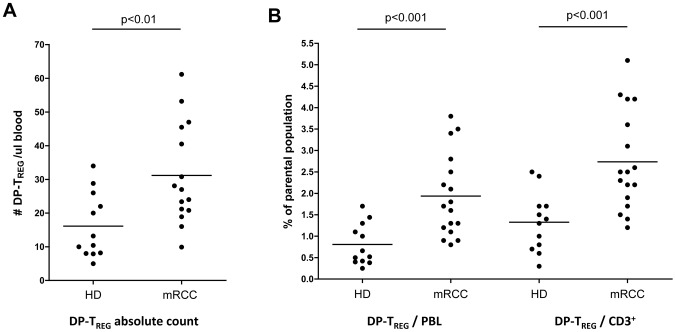
nTREGs are increased in the peripheral blood of RCC patients.(A) Absolute numbers (HD = 12, mRCC = 15, for patients #3, #6 and #18 a complete blood count from the day of the elutriation was not available) and (B) frequencies of TREG in the circulation of HD (n = 12) and patients with mRCC (n = 17, all but patient #15).